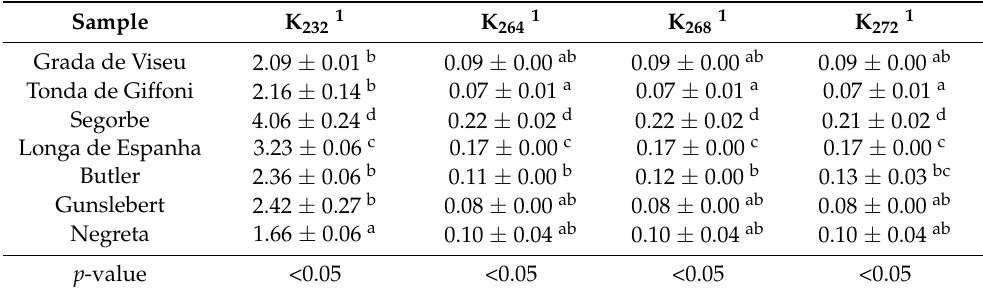
Table 7. Hazelnuts’ specific extinction coefficients at 232, 264, and 268 e 272 nm (mean ± standard